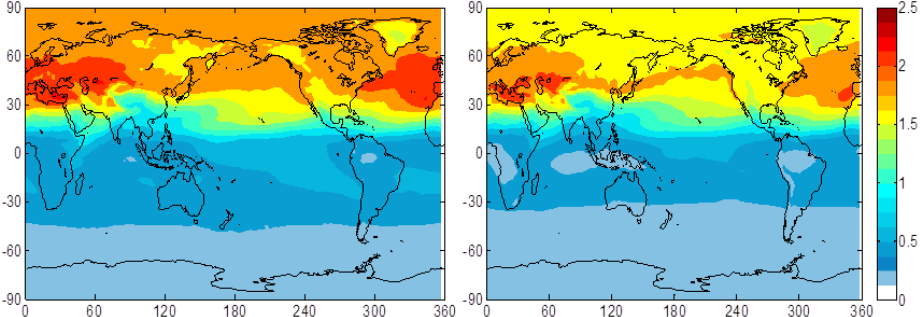
Figure 7. Yearly mean perturbations of the ozone column ( 1 DU) based on 2006 aircraft NO x emissions. CAM5 is on the left, while CAM4 is on the right.